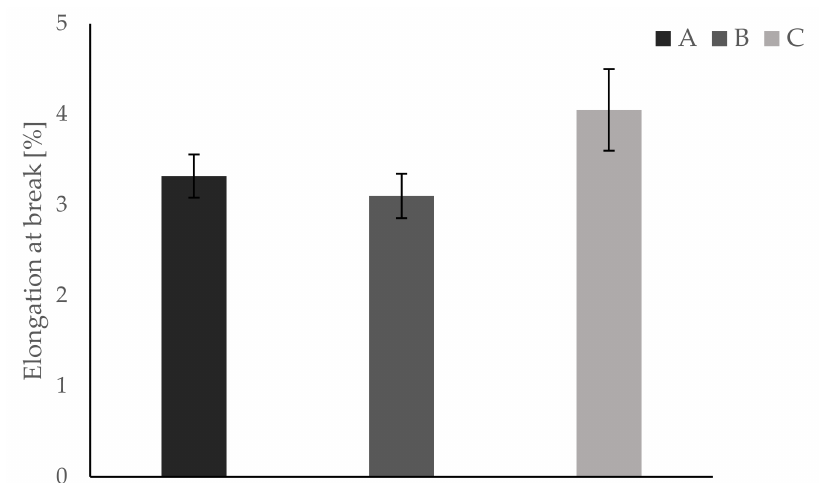
Figure 7. Bending tests reveal an increased elongation at break for group C compared to groups A and B (increase of > 20%).